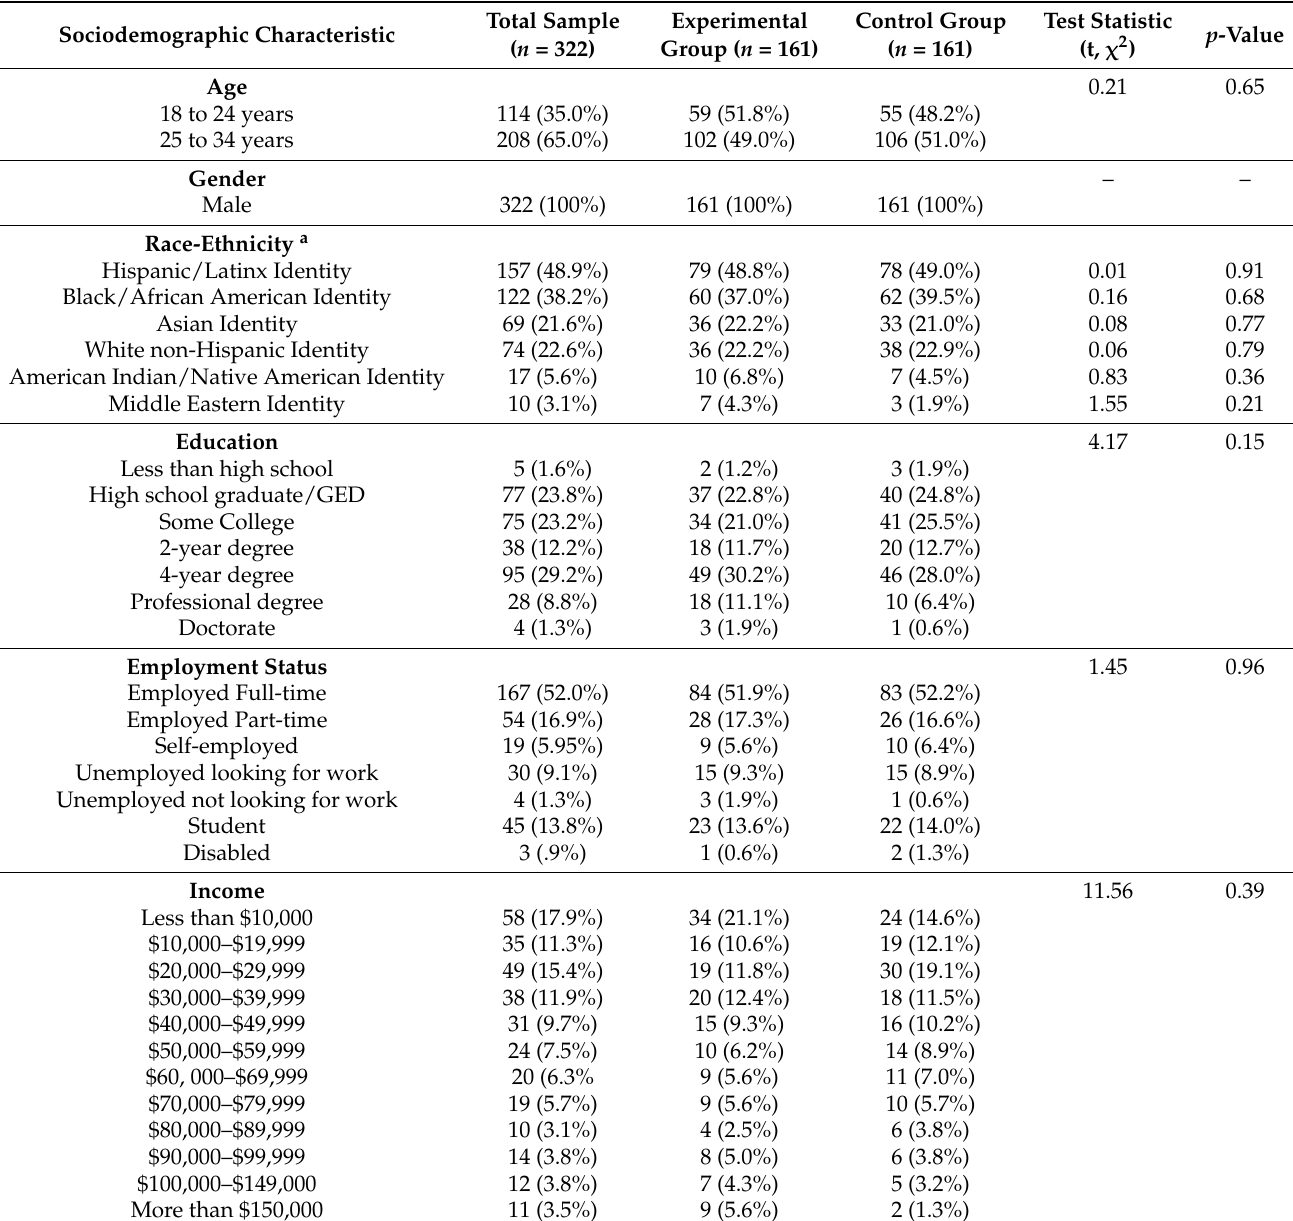
Table 1. Between-group differences on sociodemographic